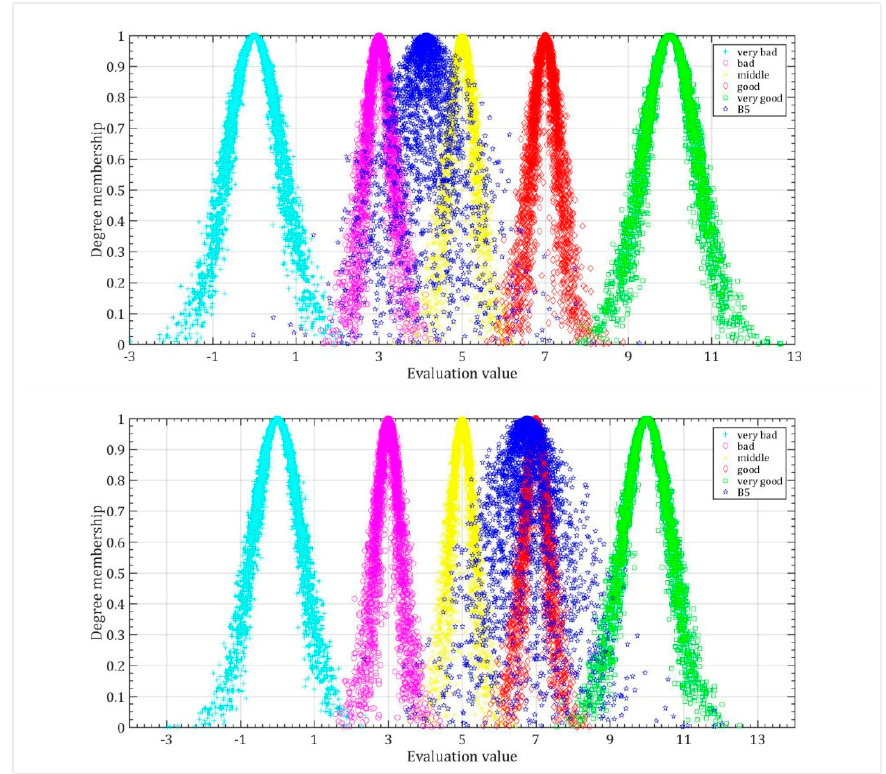
Figure 14. Cloud image of welfare evaluation grades of development opportunities of land-lost farmers’ households under different livelihood assets .